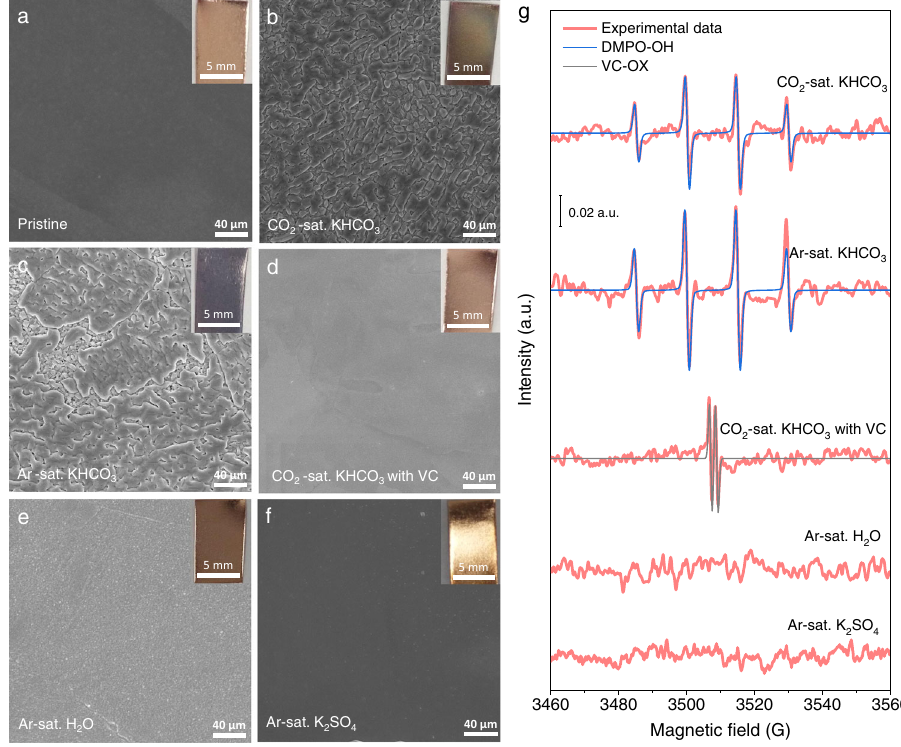
Fig. 4 Oxidizing corrosion of the polished Cu plates in different solutions. SEM images of Cu plates before a , and after 24 h oxidizing corrosions in b CO 2 -saturated KHCO 3 , c Ar-saturated KHCO 3 , d CO 2 -saturated KHCO 3 containing VC, e Ar-saturated ultrapure water, and f Ar-saturated K 2 SO 4 solutions. Correspondingly, the photographs are displayed in insets. g EPR spectra of the corresponding solutions containing 100 mM DMPO after 24 h resting. The concentrations of KHCO 3 , K 2 SO 4, and VC are 0.5 M, 0.25 M, and 10 mM,